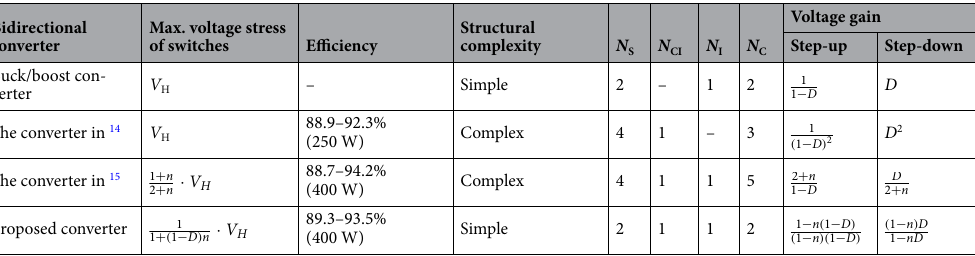
Table 3. Characteristic comparison of the proposed converter with the main competitors.